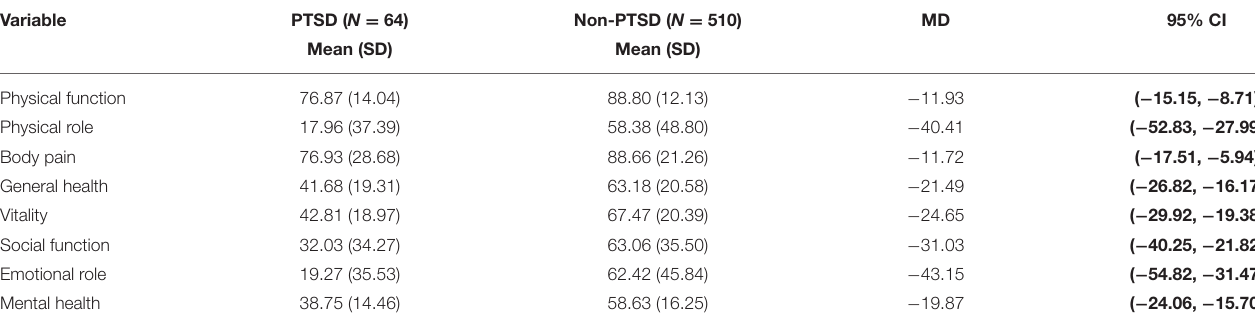
TABLE 3 | Quality-of-life scores for PTSD and dimensions (mean ± SD).